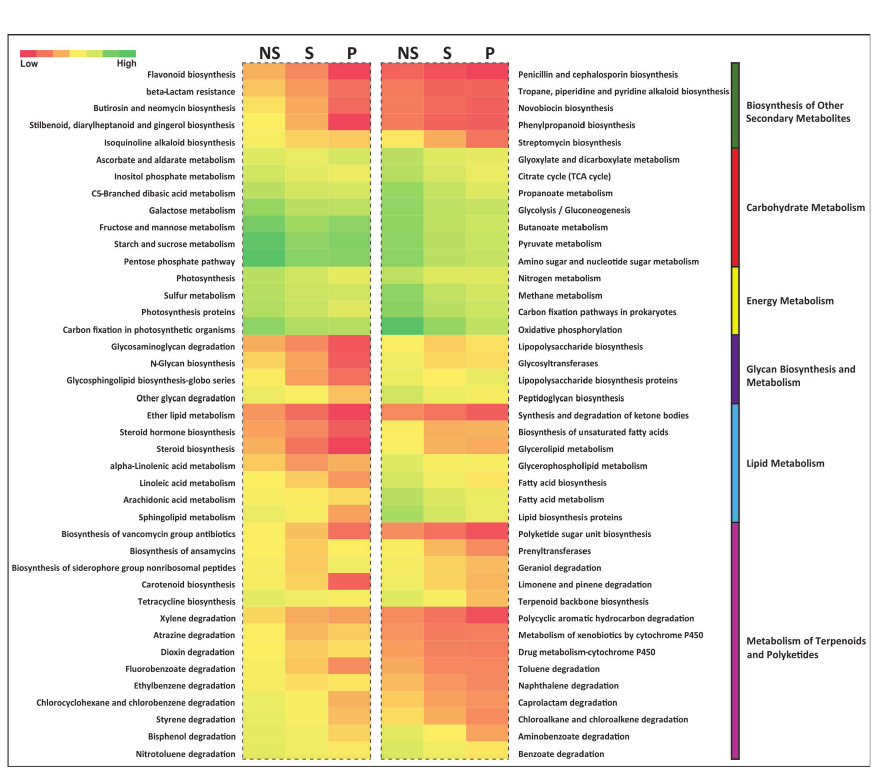
Fig. 4. Functional capacities regarding with metabolism of the root associated soil microbiome. This heatmap showed relative abundance of representative functions which are derived from the PICRUSt tool and greengene 13.8